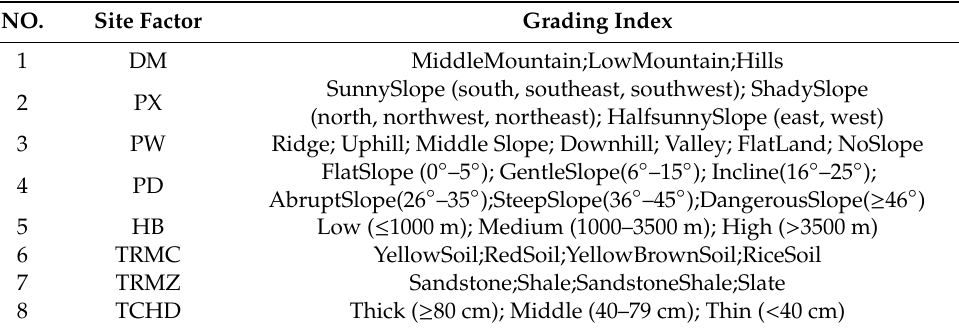
Table 2. Site factors and their classification indexes.